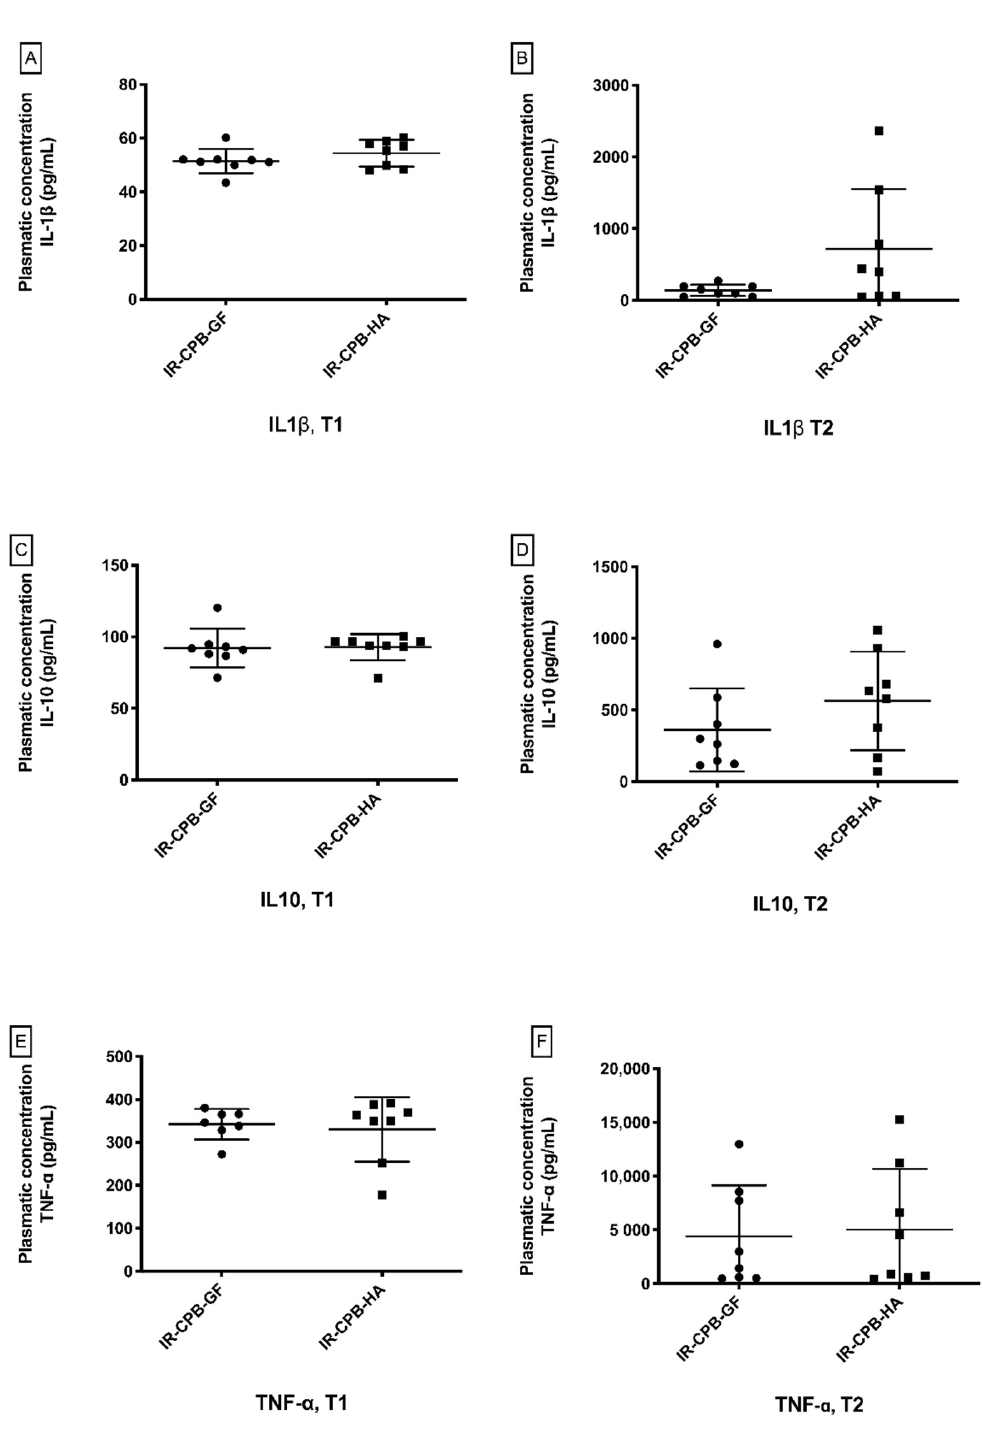
Figure 3. Systemic inflammation. ( A ) Mean value of IL-1 β plasma level at T1. ( B ) Mean value of IL-1 β plasma level at T2. ( C ) Mean value of IL-10 plasma level at T1. ( D ) Mean value of IL-10 plasma level at T2. ( E ) Mean value of TNF- α plasma level at T1. ( F ) Mean value of TNF- α plasma level at T2. For statistical analyses, ANOVA was used, followed by Tukey’s multiple comparison (post hoc) testing. A result with p < 0.05 was considered to be statistically significant. Data are presented as mean ± SD. Abbreviations: CPB, cardiopulmonary bypass; IR, left lung ischemia–reperfusion; HA, human albumin.